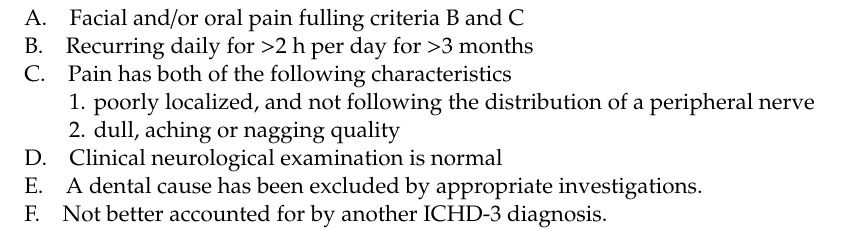
Table 3. Persistent idiopathic facial pain (PFIP). The ICHD-3 criteria for the diagnosis of persistent idiopathic facial pain (ICHD, Cephalalgia 2013,